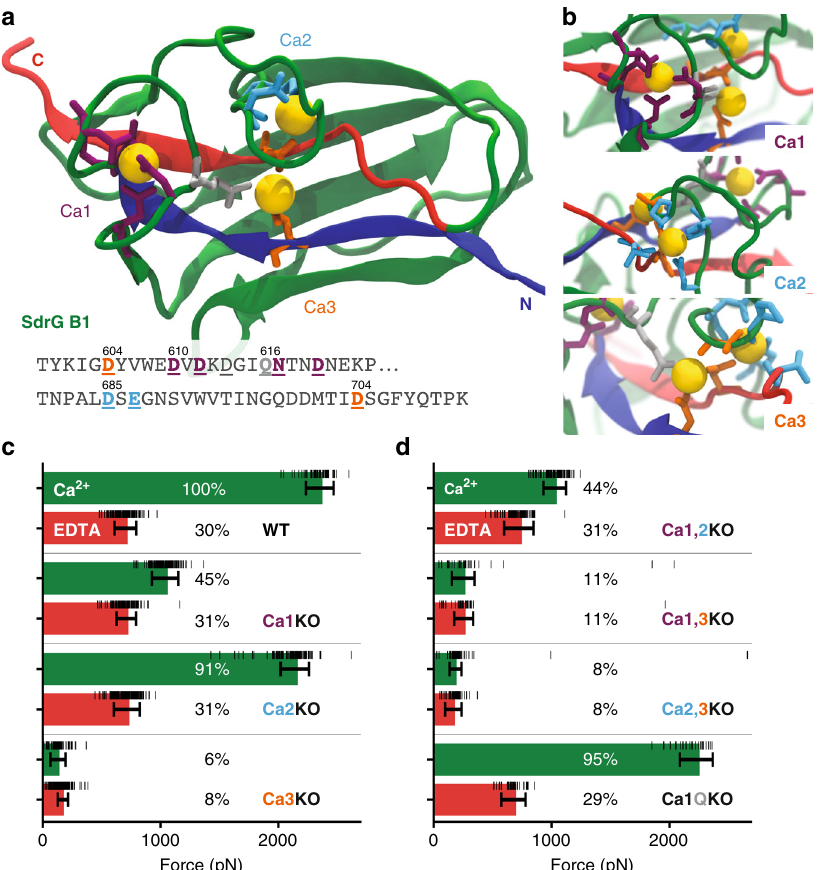
Fig. 3 Ca 2 + loop three is most important to SdrG B1 domain stability. a Equilibrated homology model of SdrG B1, with N- and C-terminal ß-strands marked in blue and red, respectively. Ca 2 + coordinating amino-acid side chains shown as sticks. Ca 2 + binding sites one to three are marked (Ca1 purple, Ca2 cyan, Ca3 orange). A conserved glutamine bridge (light gray) connects the Ca1 loop to Ca3. Amino acids mutated to remove respective loops are underlined